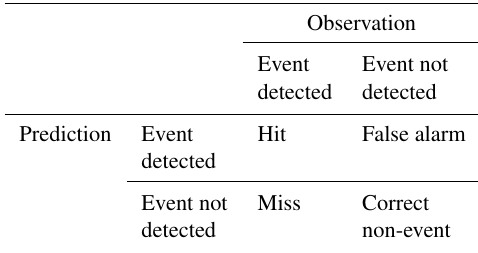
Table 2. Contingency table for the categorical